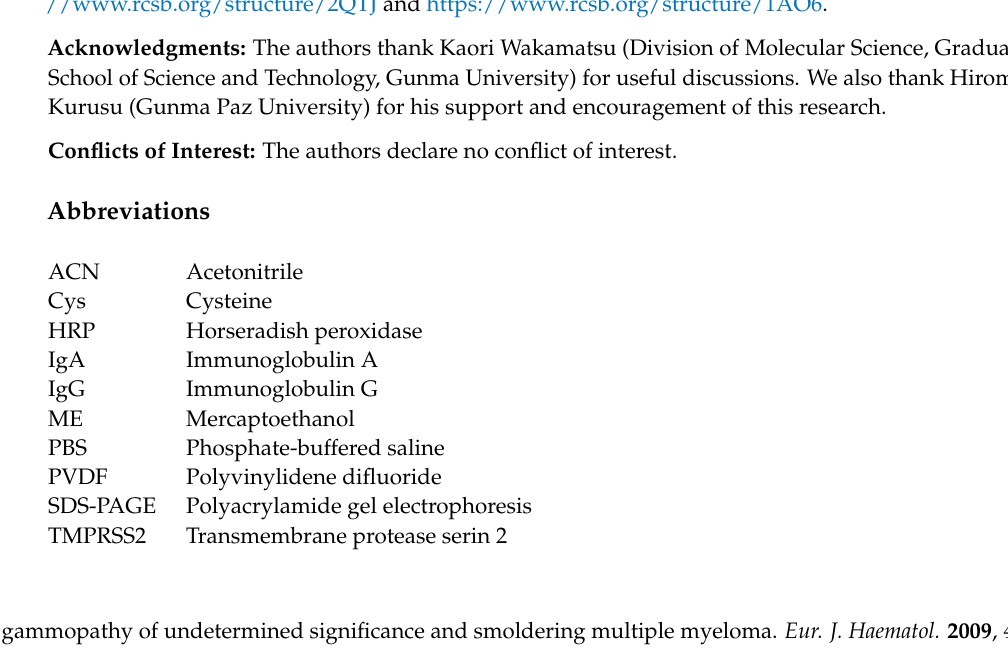
sera. Supplemental Table S4: Peptides identified from the purified polyclonal IgA from normal sera. Supplemental Figure S1: Noncovalent molecular interactions between IgA and